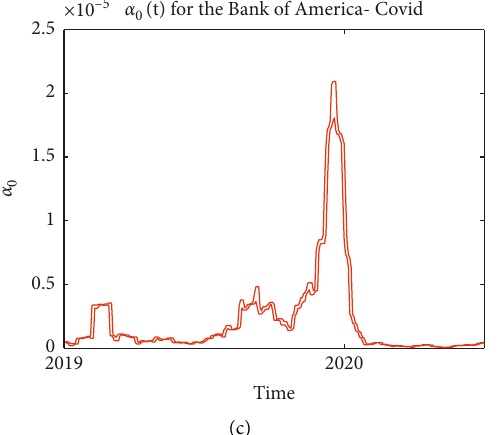
33.544.555.566.5